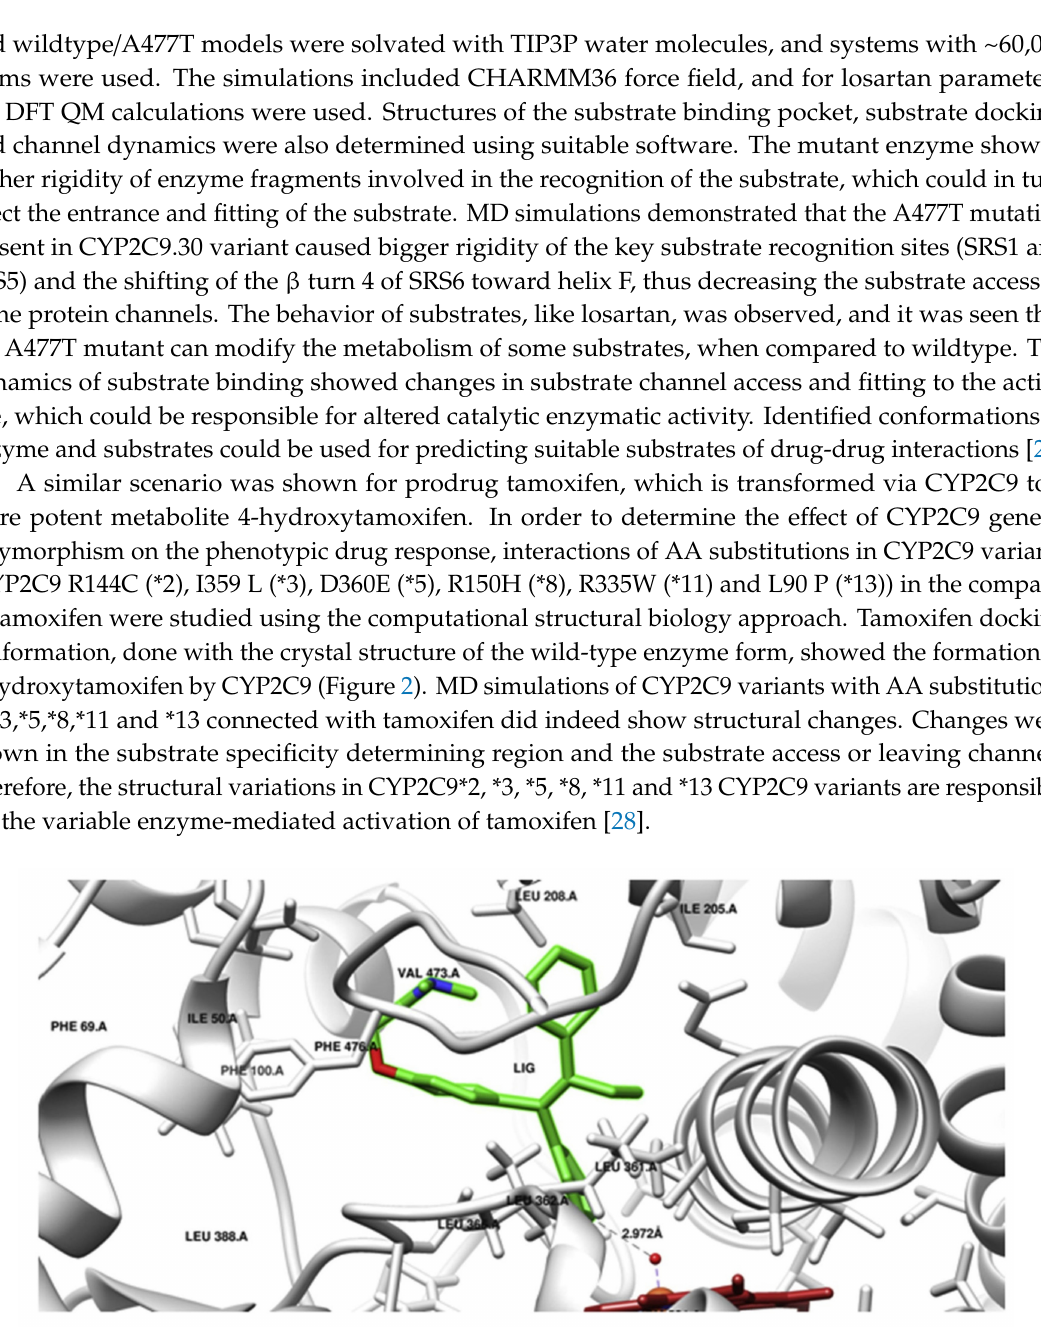
Figure 2. Molecular docking (Autodock) of tamoxifen with CYP2C9 (PDB ID 1OG5). Tamoxifen (LIG) in 4-hydroxy orientation is presented in green, and heme is shown in red. The prodrug 4-hydroxylation site is towards oxyferryl species (5 Å distance); the Ligplot analysis non-bonded contacts of tamoxifen with amino acid residues of SRS5 (LEU 362, LEU 366), SRS6 (PHE 476, ALA 477), SRS2 (ILE 205, LEU208), SRS4 (ALA 297, THR 301) were observed. Docking of tamoxifen with CYP2C9 is consistent with the tamoxifen metabolism pathway. Reproduced with permission from